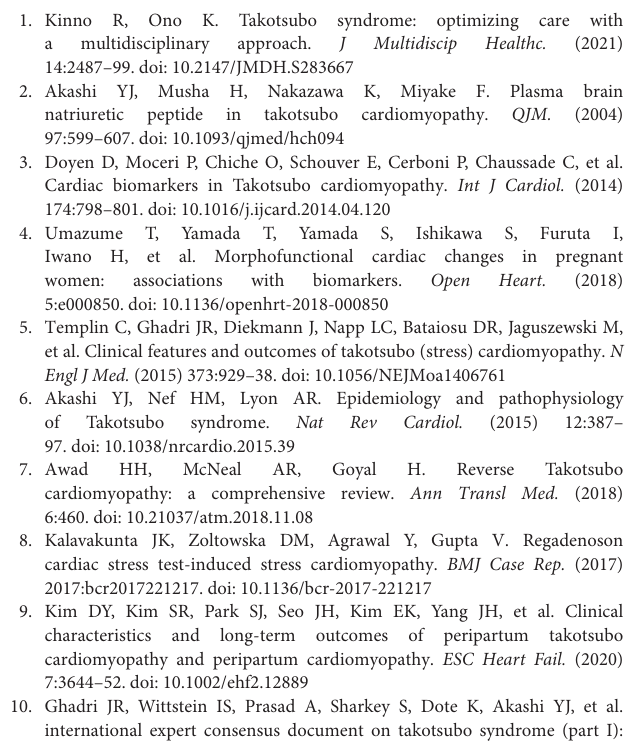
Takotsubo syndrome.